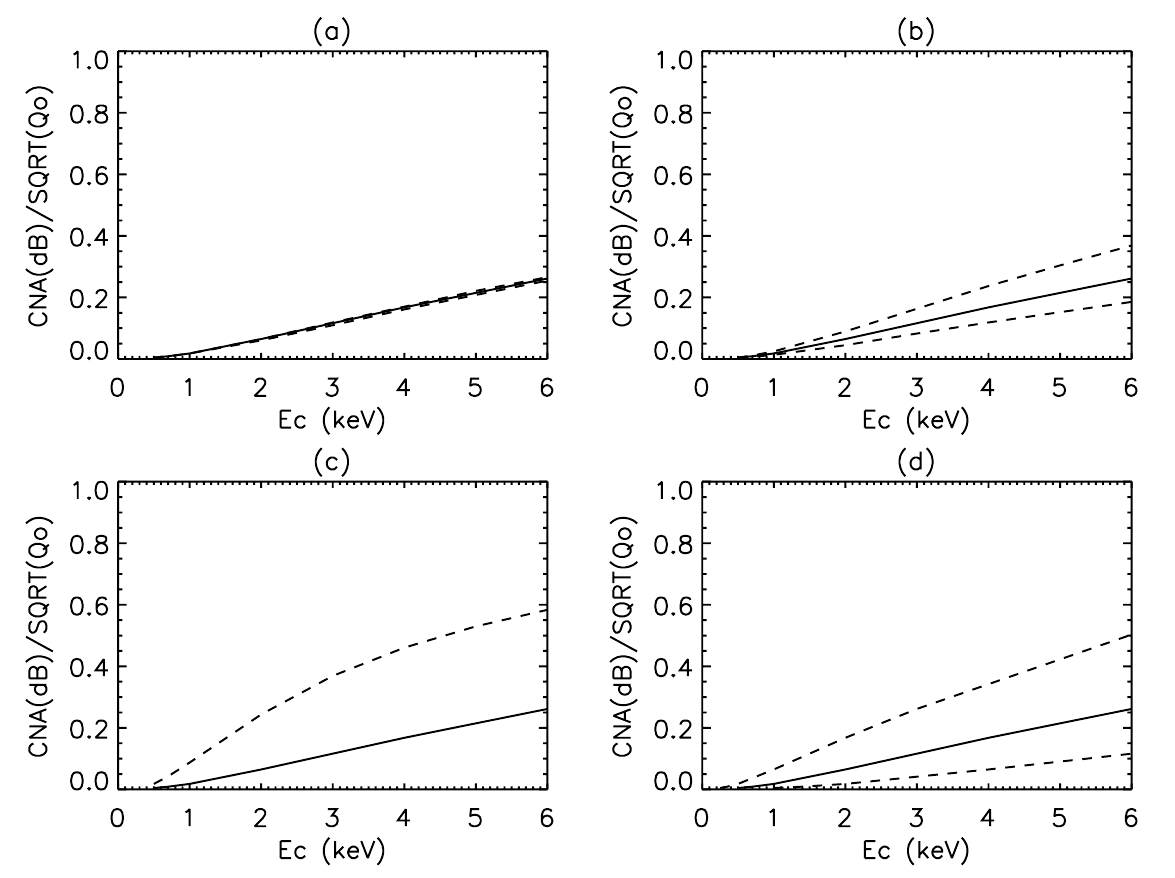
Fig. 6. Variation range of the theoretically estimated curve (broken lines), when the uncertainty of various atmospheric parameters are taken into consideration. The solid line in each figure represents the theoretically estimated curve using average atmospheric parameters. (a) Variation range corresponding to the variation of the parameters f10.7 and A p index in the atmospheric model MSIS-90 during the period of 79-day data set. (b) Variation range corresponding to the increase and decrease of the effective recombination coefficient by a factor of 2. (c) Theoretically estimated curve when the electron temperature in the E-region of ionosphere rises to 2000 ◦ K (broken line). (d) Variation range corresponding to the increase and decrease by a factor of 2 of the conversion relation of the ratio of 427.8nm and 630.0nm brightness into the characteristic energy E c